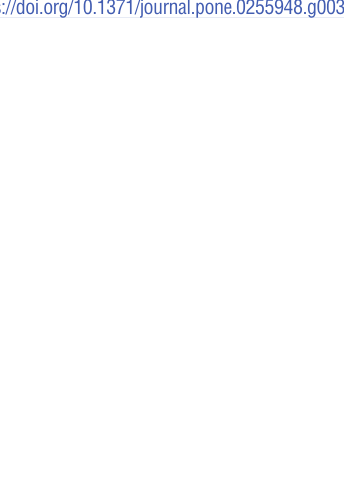
PLOS ONE | https://doi.org/10.1371/journal.pone.0255948 August 19, 2021 12 /